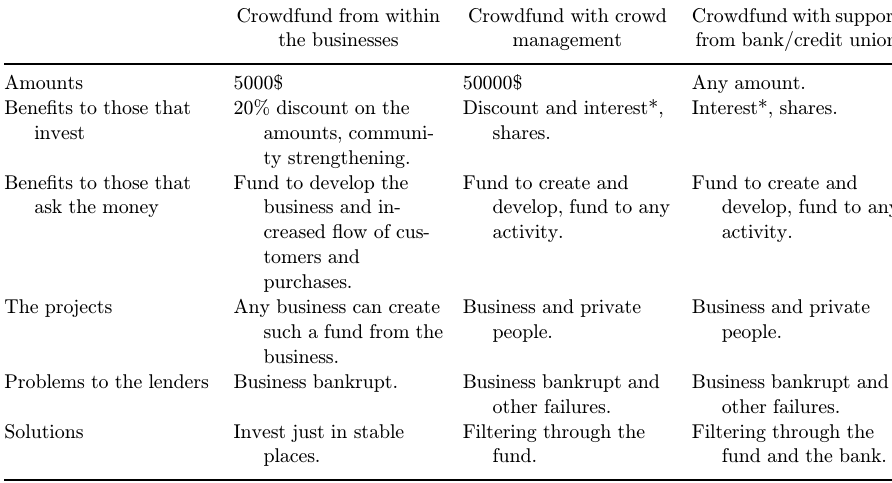
Table 2. The three unique crowdfunding approaches to replace biased